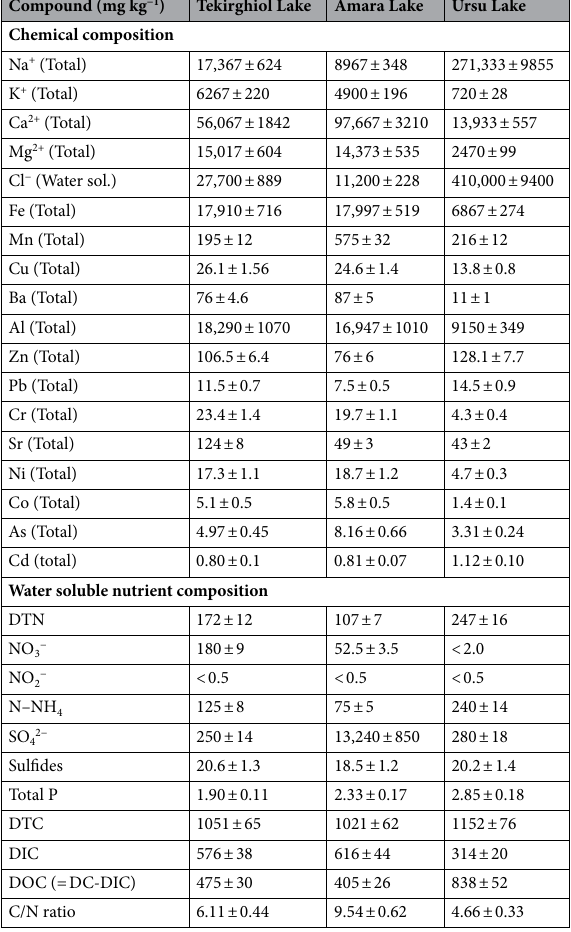
Table 5. Chemical and nutrient composition (average ± standard deviation of three replicates) of the sediments collected from Tekirghiol, Amara and Ursu lakes. Total—sediments were dried and extracted with aqua regia , therefore values are meant for total mineral contents; Water sol.—sediments were levigated 1/10 in water, therefore values are meant for water soluble minerals.